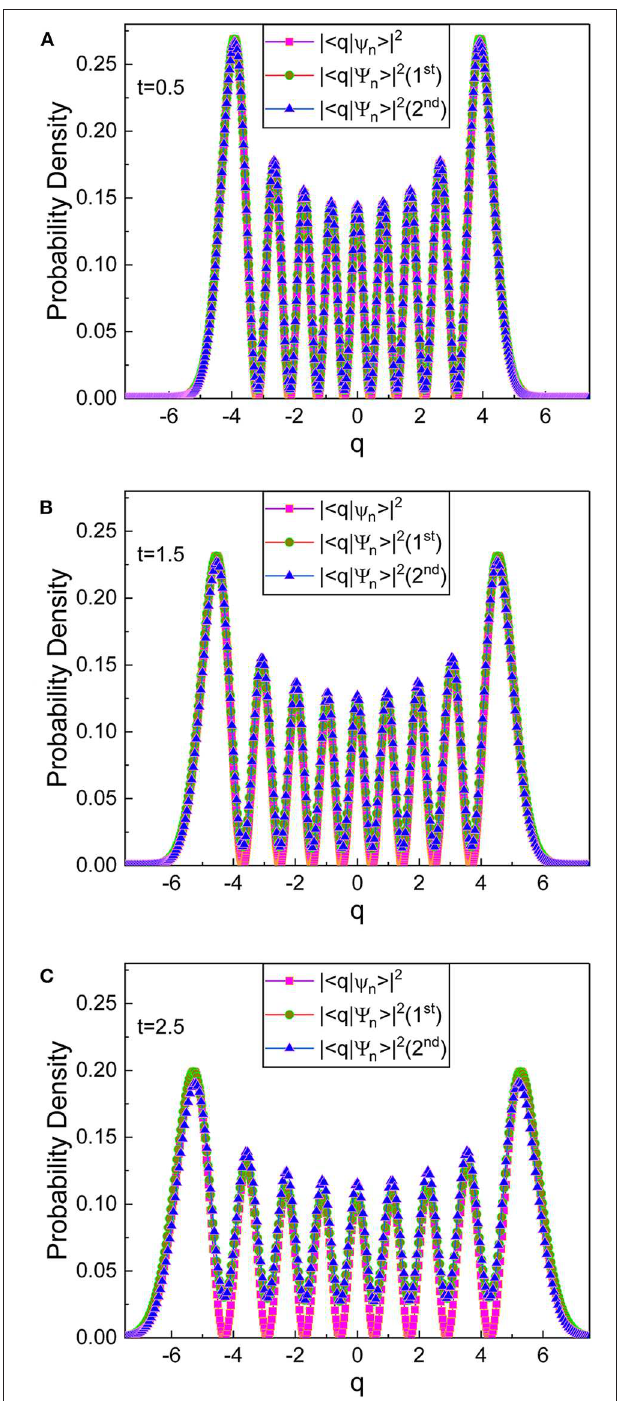
2 (for the wave functions q ψ n FIGURE 1 | The probability densities |h | i| 2 (for the wave functions Equation 19) for the system q 9 n Equation 13) and |h | i| described in Equations (36)–(38), where t is 0.5 for (A) , 1.5 for (B) , and 2.5 for (C) . The characters 1 st and 2 nd in the figure legends mean that the corresponding figure has been plotted with the consideration up to the first order and up to the second order of ǫ , respectively. The parameters are h c 2 chosen as 1, β 0.3, ω 0 1, m 0 1, n 8, c 1 1, ǫ 0.0035, = = = = = = = = ¯ b and a 1. = =